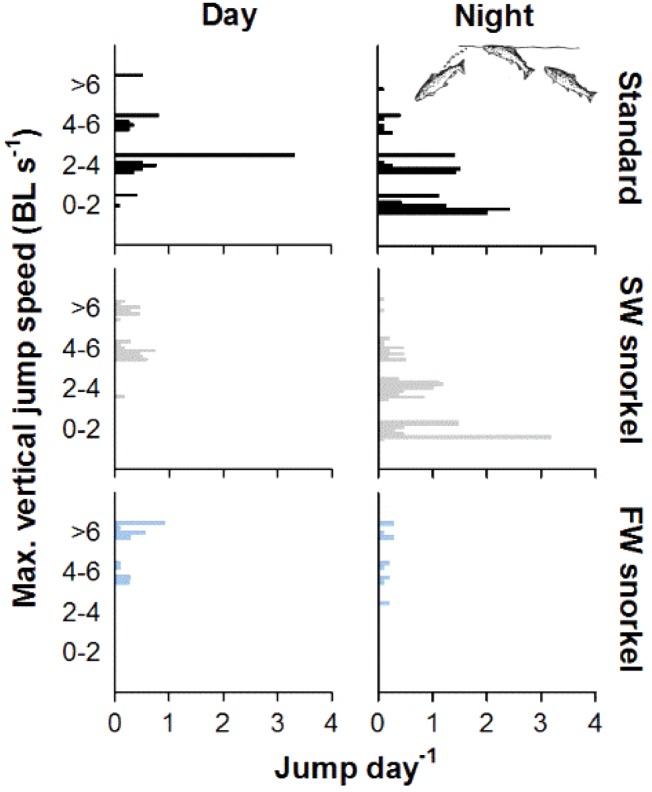
Individual jumps day−1 plotted against maximum jumping speed in the vertical plane at 2 BL sec−1 intervals for surviving tagged salmon in standard (black), SW (grey), and FW snorkel cages (blue bars) separated between day and night periods. Source: Image modified from Korsøen et al. 2012b.